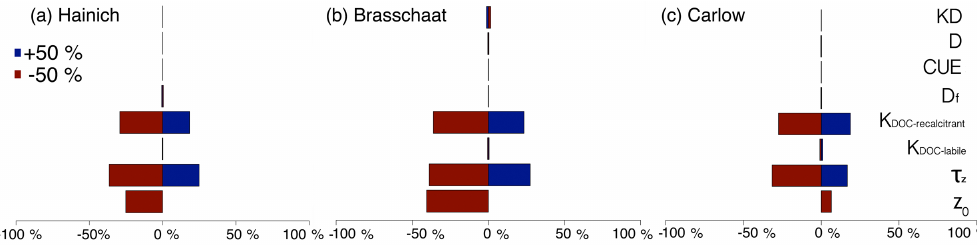
Figure 8. Relative change in simulated DOC (%) for a + 50% (blue) and − 50% (red) change in each parameter for Level 1 sites: (a) Hainich, (b) Brasschaat, and (c) Carlow. Values are given in Table